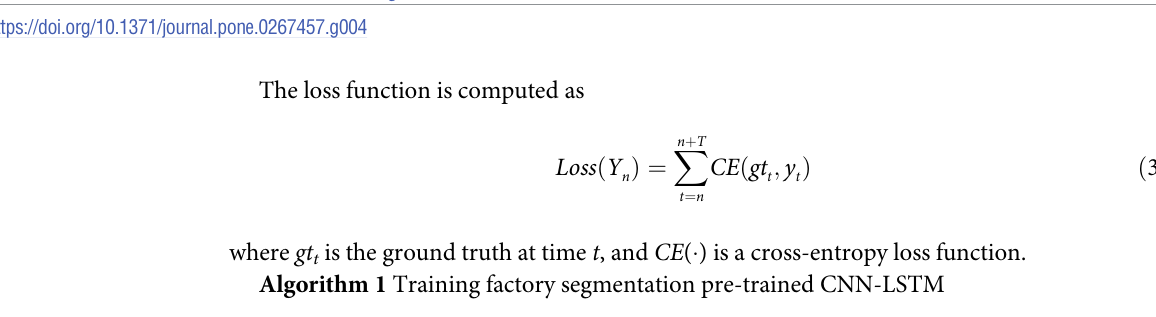
Algorithm 1 Training factory segmentation pre-trained CNN-LSTM